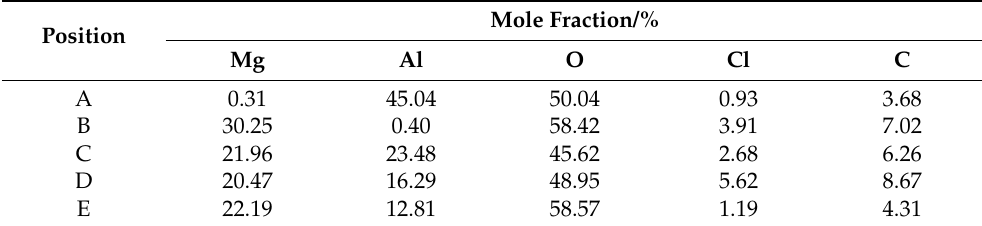
Table 5. EDS results of the distinct regions are presented in Figure 8.